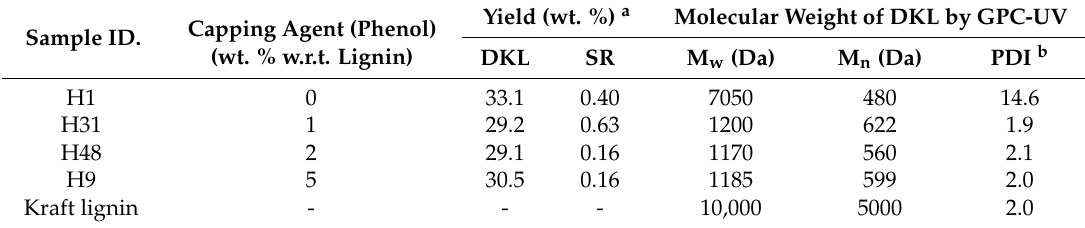
Table 4. Effects of phenol addition to black liquor on M w , polydispersity and yield of DKL at 250 ◦ C for 2 h. Sample